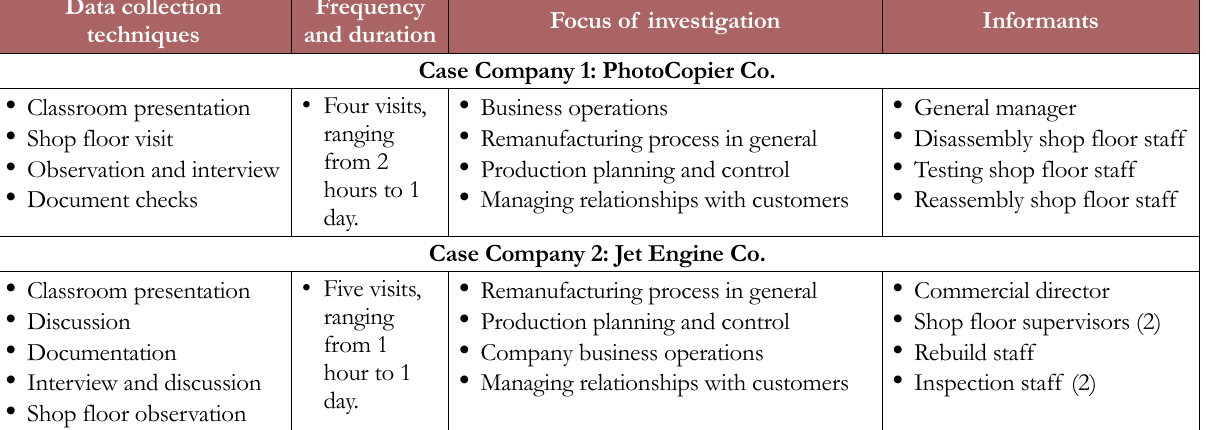
Case Company 2: Jet Engine Co.